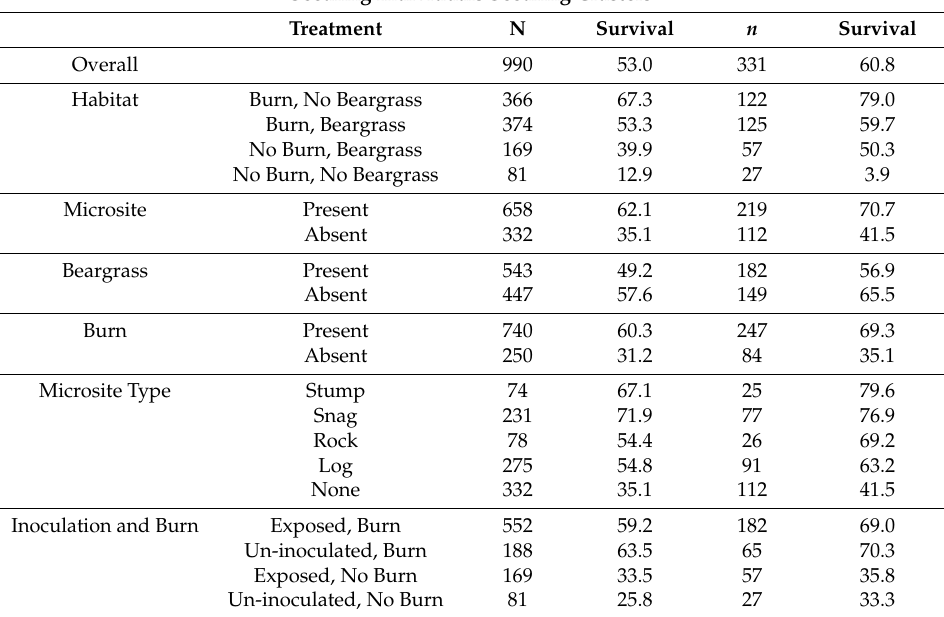
Table 1. Sample size, and probability of survival (%) after 7 years for each treatment. ‘Seedling Individuals’ refers to the analysis of each seedling separately. ‘Seedling Clusters’ refers to the analysis of each group of three seedlings as a single entity; even if only one seedling survives in a cluster, the whole cluster is considered alive.